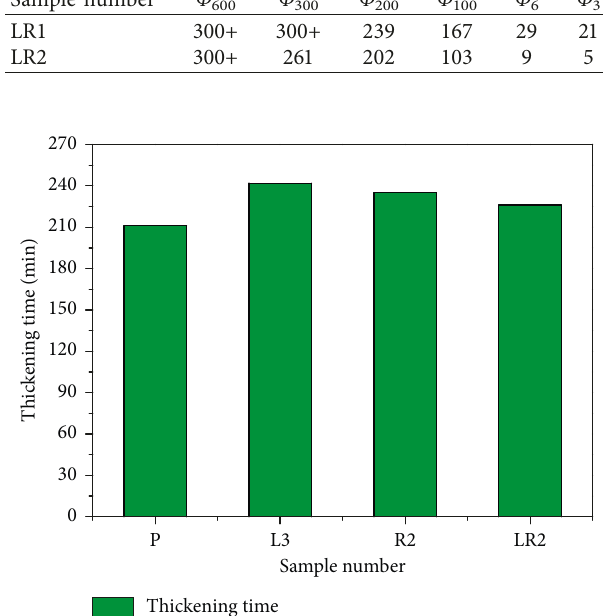
Figure 7: Dependence of rubber and latex on thickening time of cement slurry.